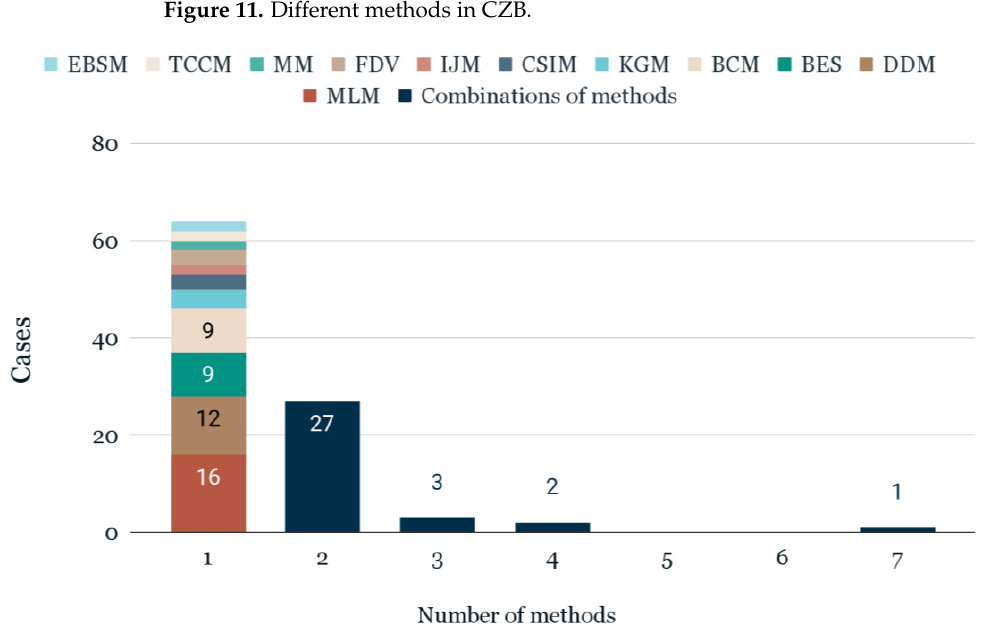
Figure 12. Frequency of the number of methods used for CZB.